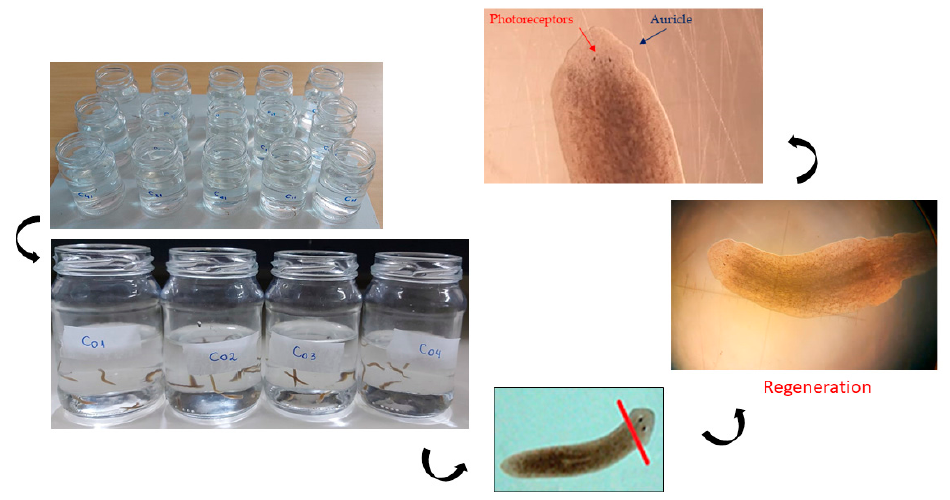
Figure 3. Photograph of the regeneration of photoreceptors and auricles of G. tigrina . The physical-chemical parameters for monitoring the tests are shown in Table 5. Table 5. Physicochemical parameters for monitoring ecotoxicological tests.